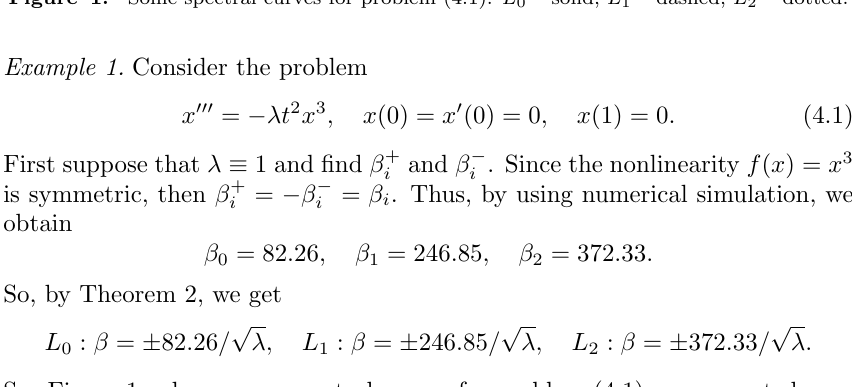
Figure 1. Some spectral curves for problem (4.1). L 0 – solid, L 1 – dashed, L 2 –